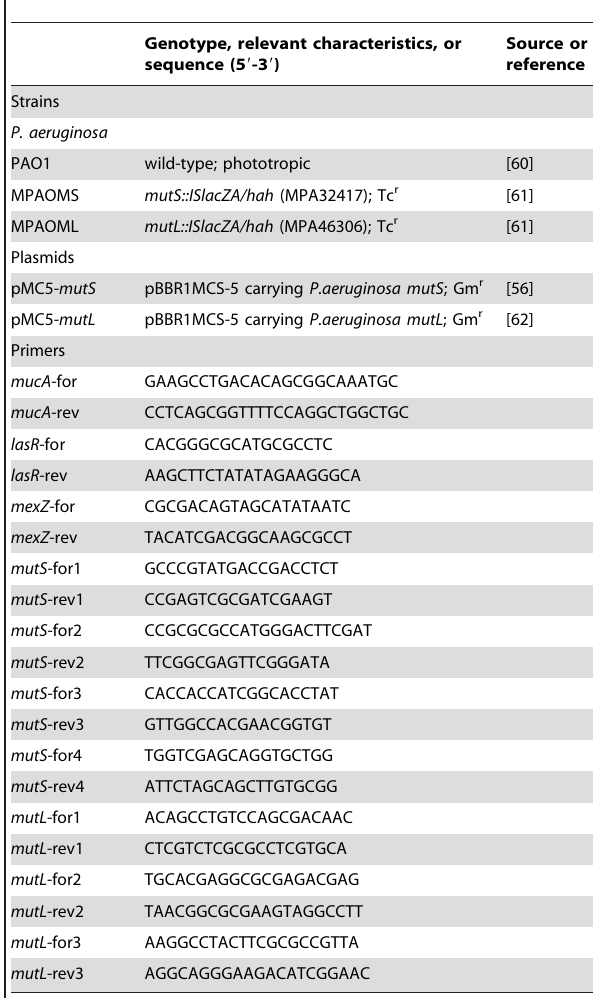
Table 4. Bacterial strains, plasmids and primers used in this